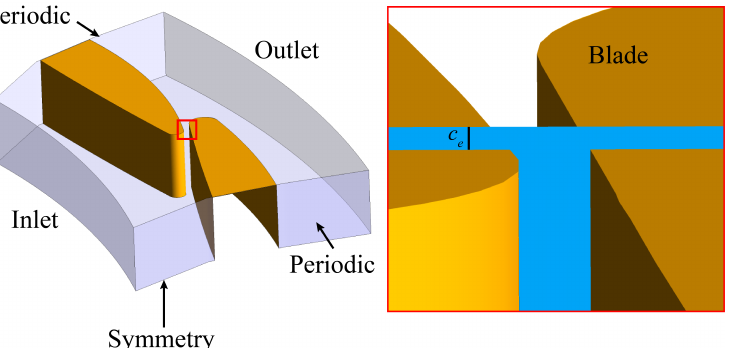
Figure 3. The computational domain of the guide vane for the 3D steady-state RANS calculations ( Left ), where c e is the unilateral end wall clearance width ( Right ).